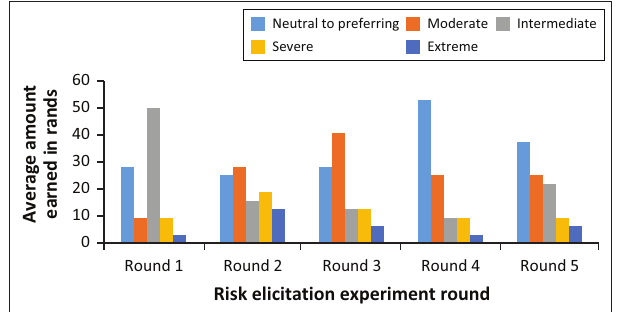
FIGURE 1: Gains only games – Distribution of risk appetite.